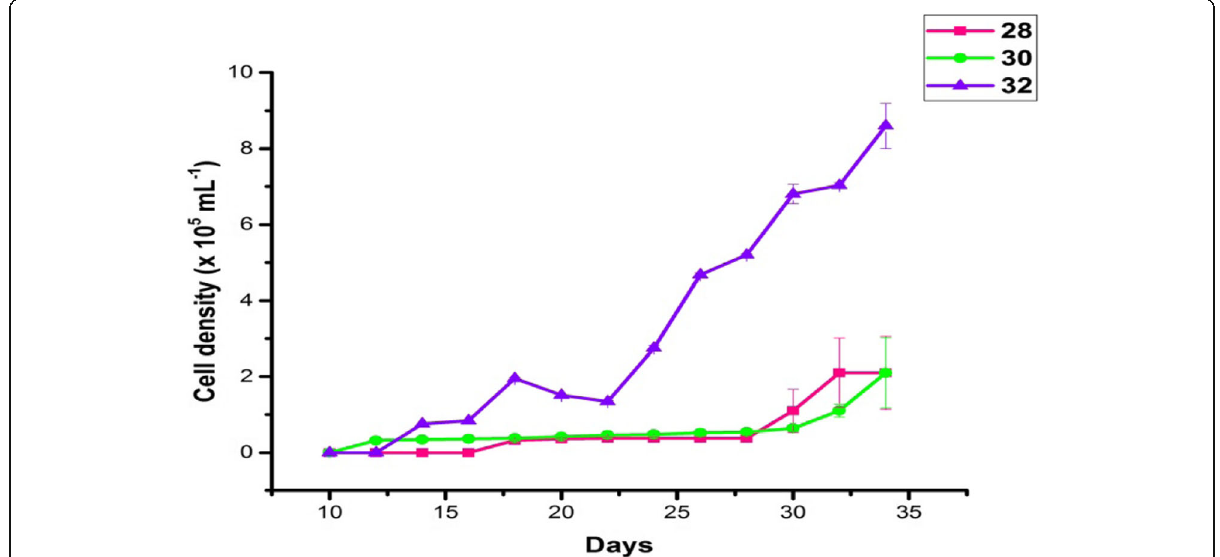
Fig. 2 Effect of salinity (PSU) on cell density in batch cultures of P.